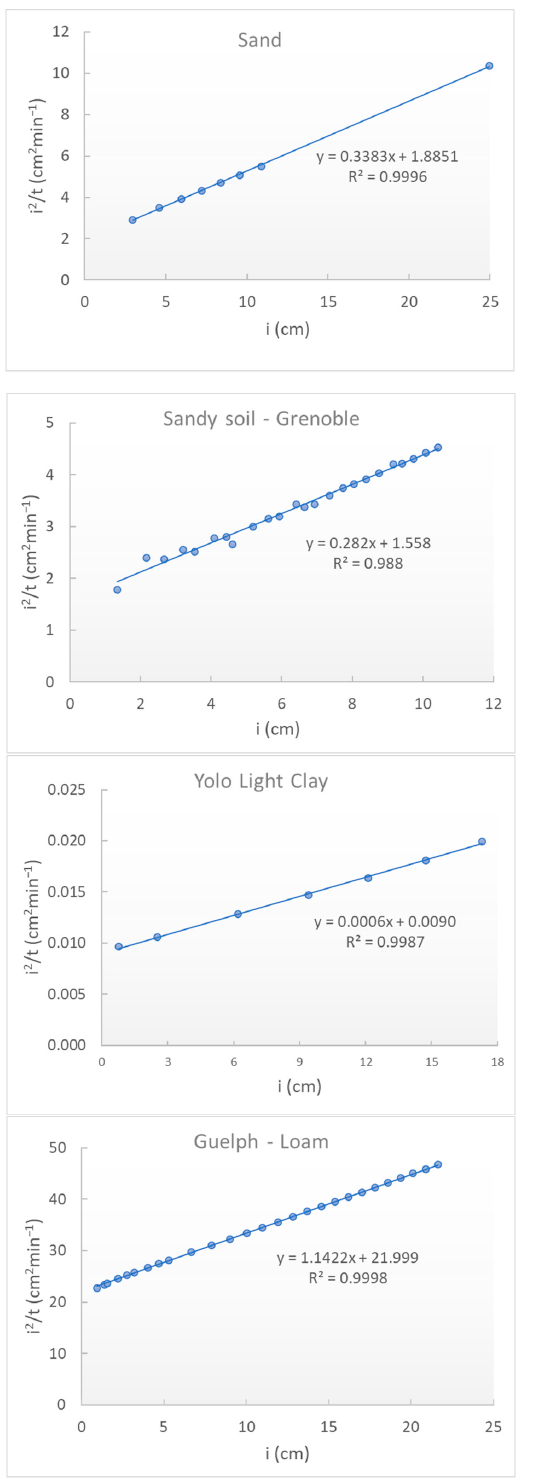
Figure 2. Linear presentation of the cumulative infiltration data using Equation (8) for the estimations of S and K s of the soils studied. S and K s are estimated from the square root of the intercept and the slope of the regression line, respectively.